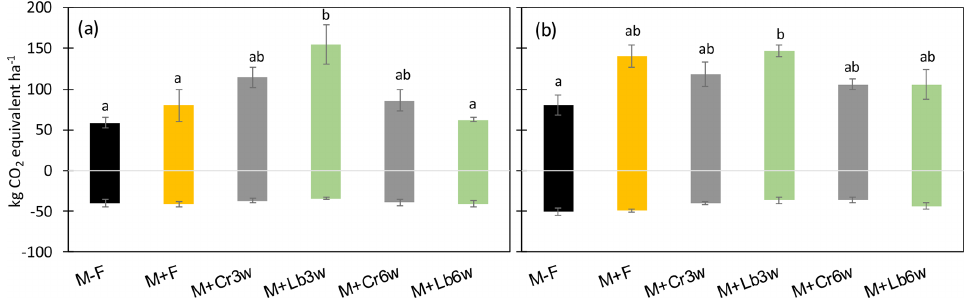
Figure 5. Relative contribution of CH 4 uptake and N 2 O emissions to seasonal total non-CO 2 GHG emissions in mono-cropping and inter- cropping treatments in 2015 (a) and 2016 (b) . Error bars indicate standard deviation ( n =